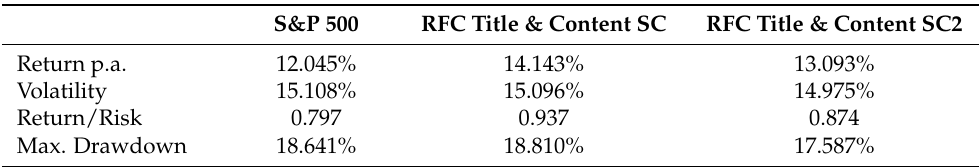
Figure 11. Out-of-sample performance random forest classification based on title and content senti- ment scores. Table 10. Performance measures of strategies based on RF classification on title and content sentiment scores from 1 January 2011 to 16 August 2016. S&P 500 RFC Title & Content SC RFC Title & Content SC2 Return